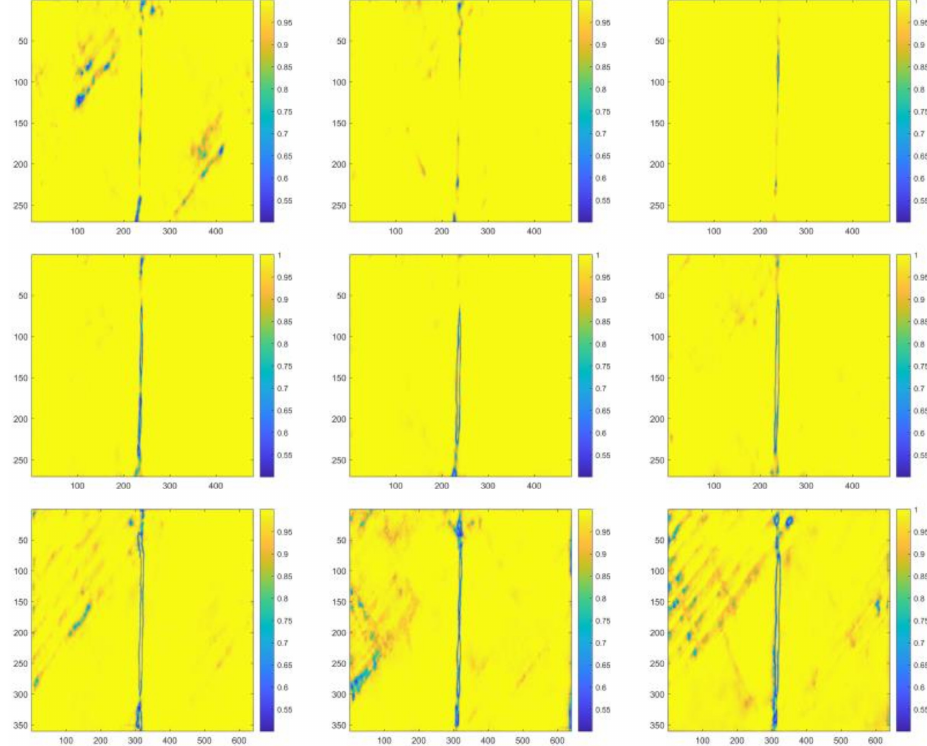
Figure 16. Visualized segmentation results in the heat map form of the same representative testing image with the C-T ratio of